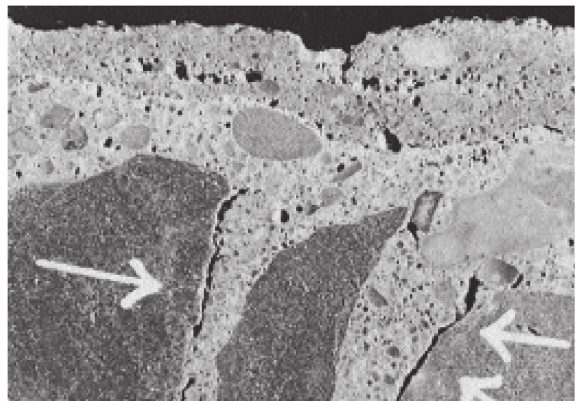
Figure 14: Effect of bleeding close to subvertical surfaces (5x).